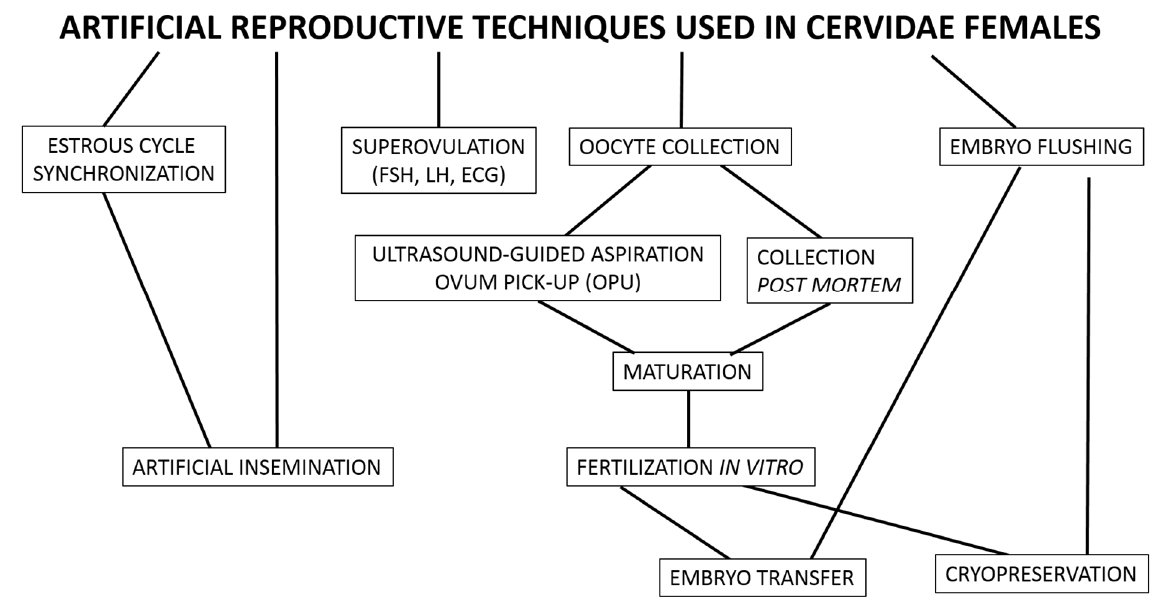
Figure 2. Artificial reproductive techniques used in Cervidae females.